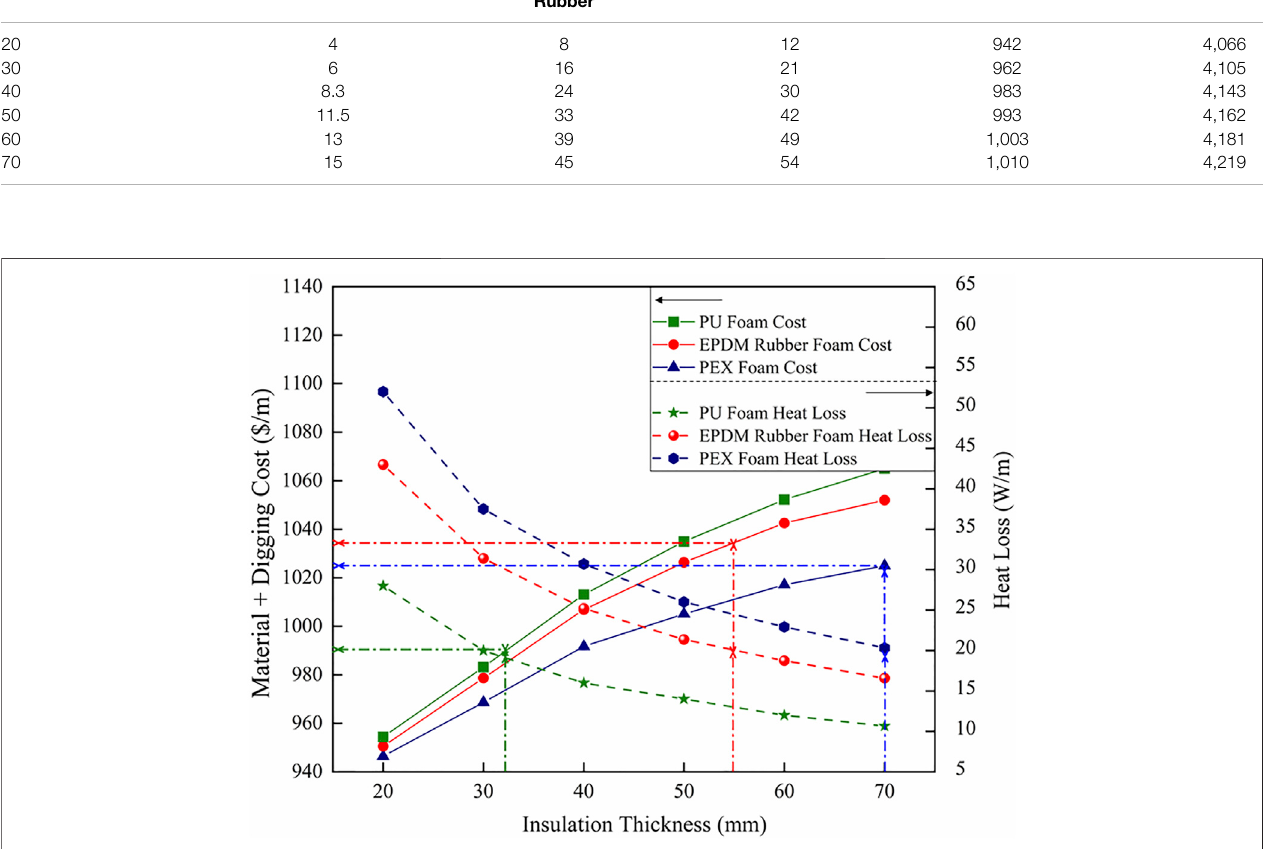
FIGURE 9 | Effect of insulation thickness on material and digging cost vs heat losses.